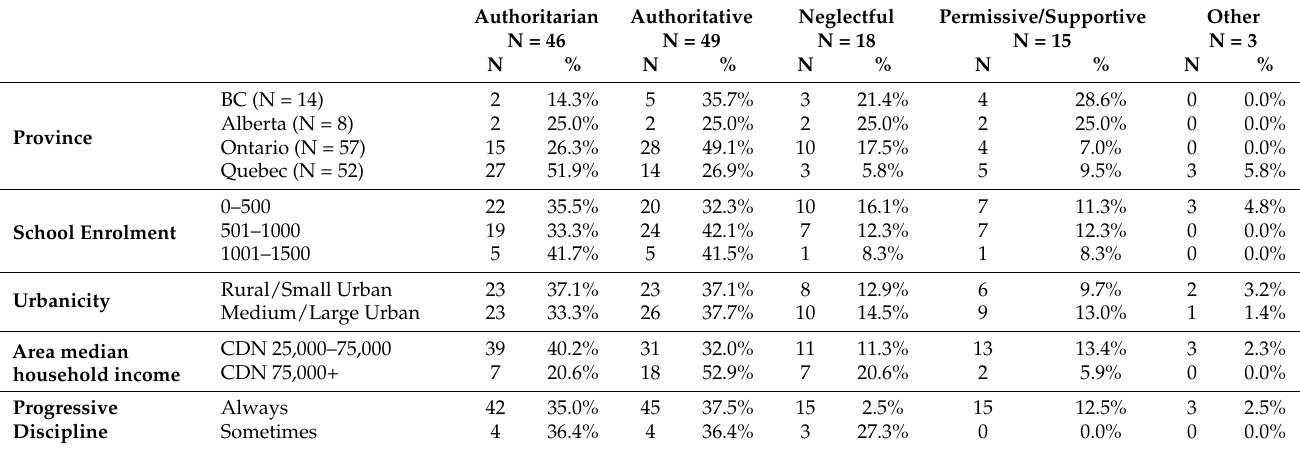
Table 2. Canadian secondary schools (n = 131) in Year 7 (2018/19) of the COMPASS Study classified into School Disciplinary Approach